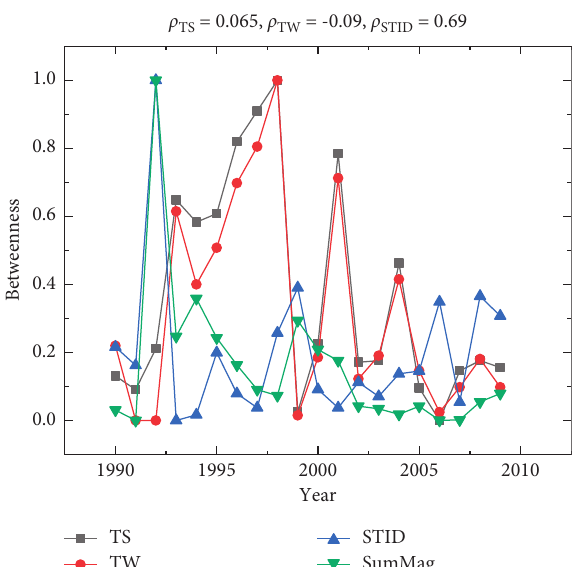
Figure 6: Evolution of the betweenness of the networks constructed by TS, TW, and STID. SumMag represents the sum of earthquake